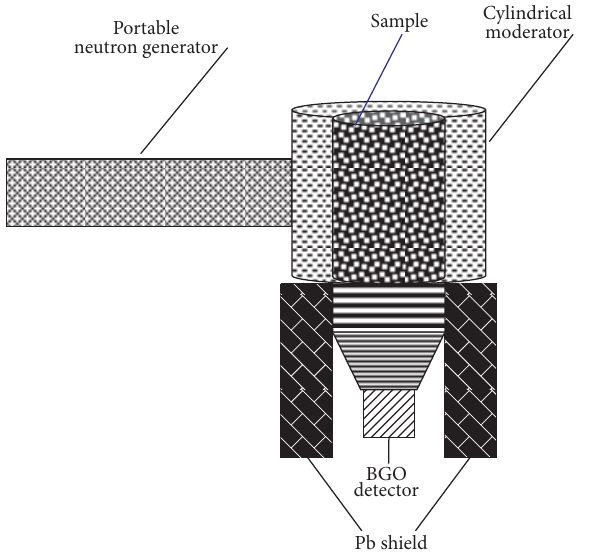
Figure 3: Schematic side view of the portable neutron generator based PGNAA setup used in the study.